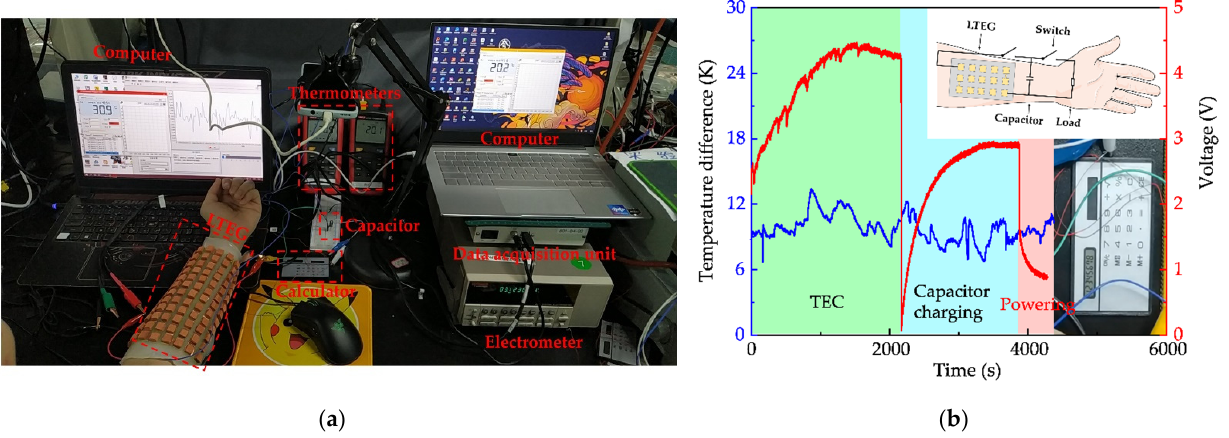
Figure 10. ( a ) The experimental scene of the LTEG wearing test; ( b ) the V OC curve of the LTEG and the terminal voltage curve when charging a 220 μ F capacitor (insets are the photo of the driven electronic calculator and the schematic diagram of the experimental